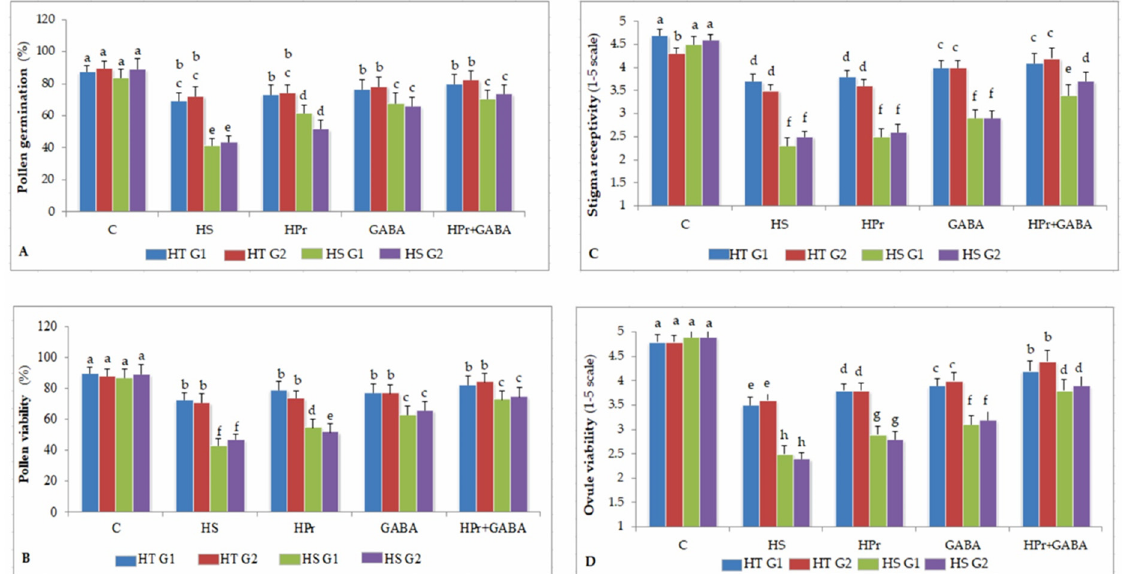
Figure 3. Effect of heat priming (HPr) and γ -amino butyric acid (GABA), applied individually or in combination (HPr+GABA) on pollen germination ( A ), pollen viability ( B ), stigma receptivity ( C ) and ovule viability ( D ) on heat- tolerant (G1: IG2507; G2: IG3263) and heat-sensitive (G1: IG2821; G2: IG2849) genotypes at stage 1 (S1) and stage 2 (S2) in heat-stressed (HS) lentil plants, compared to control ( C ). Vertical bars represent standard errors ( n = 3). Different small letters on the bars indicate significant differences from each other ( p < 0.05). LSD for interaction (genotypes × stages × treatments) ( p < 0.05): pollen germination: 6.2, pollen viability: 6.4, stigma receptivity: 0.25, ovule viability: